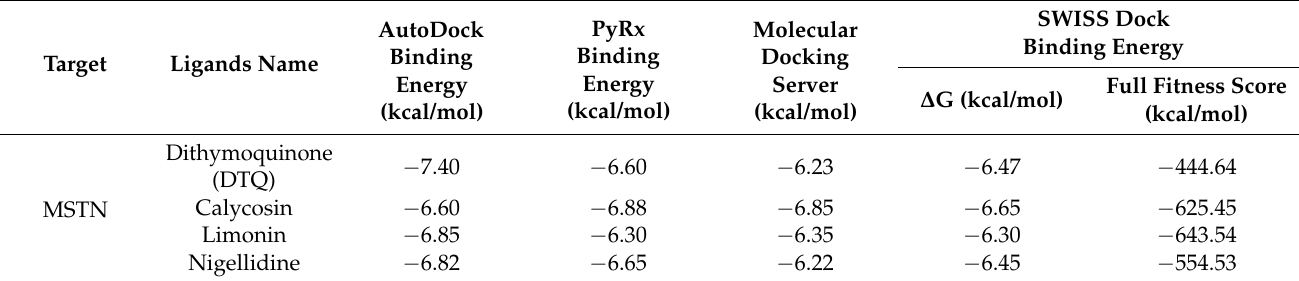
Table 3. Estimation of binding energy obtained by multiple docking tools.